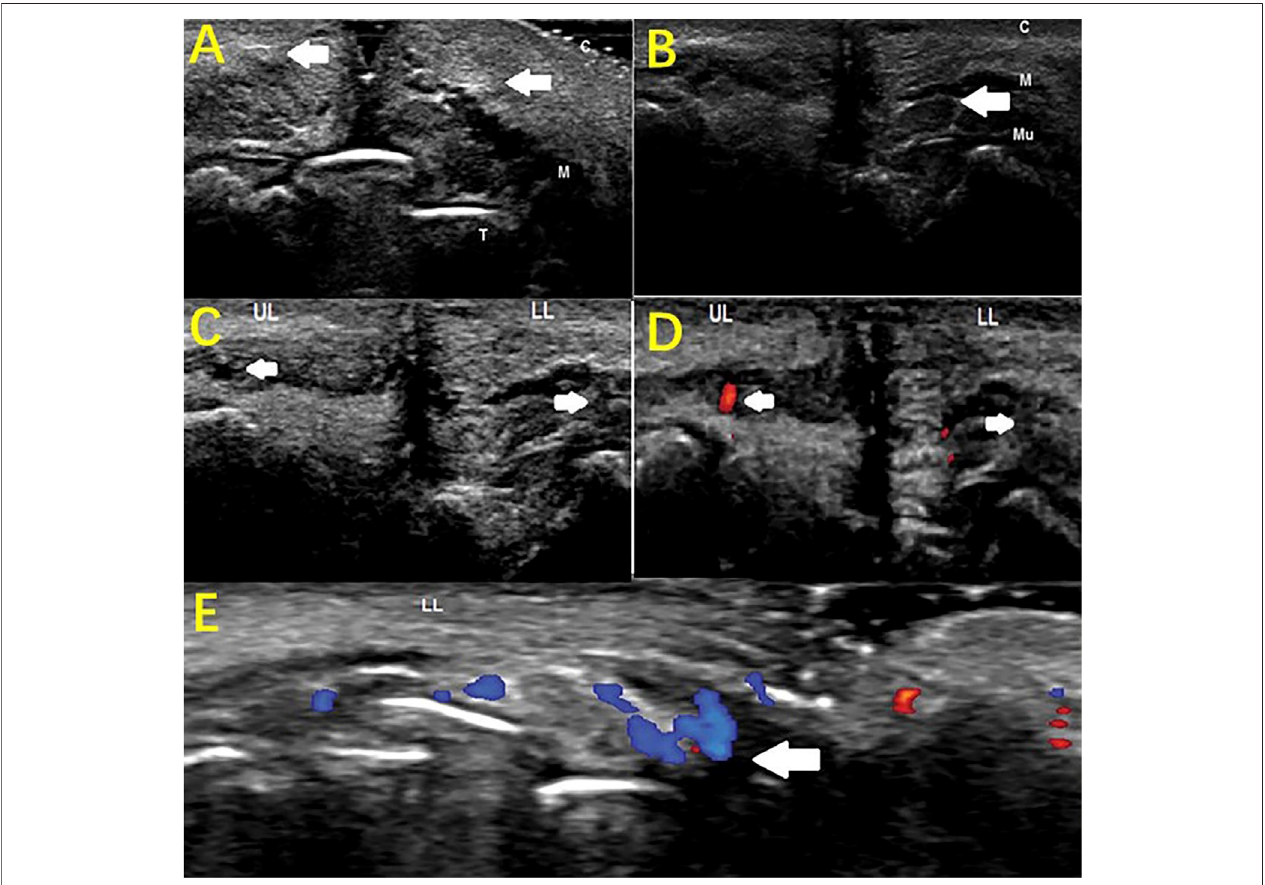
FIGURE7 | Monitoring complications ofesthetic treatments by HFUS imaging. Sagittal plane (A) Hyperechoic lips (arrows); (B) Hypoechogenic area ( fi ller deposit, arrow) surrounded by a hyperechoic region (T-teeth, M-orbicularis muscle, C-cutaneous tissue, Mu-mucosa). Sagittal plane (C) B-mode sonogram: The superior labial artery (left arrow), invisible inferior artery (right arrow); (D) Color Doppler sonogram: visible blood fl ow of the superior labial artery (left arrow), invisible blood fl ow of the inferior labial artery (right arrow); (LL: lower lip; UL: upper lip). Transverse plane (E) Color Doppler sonogram: collateral circulation of the left inferior labial artery